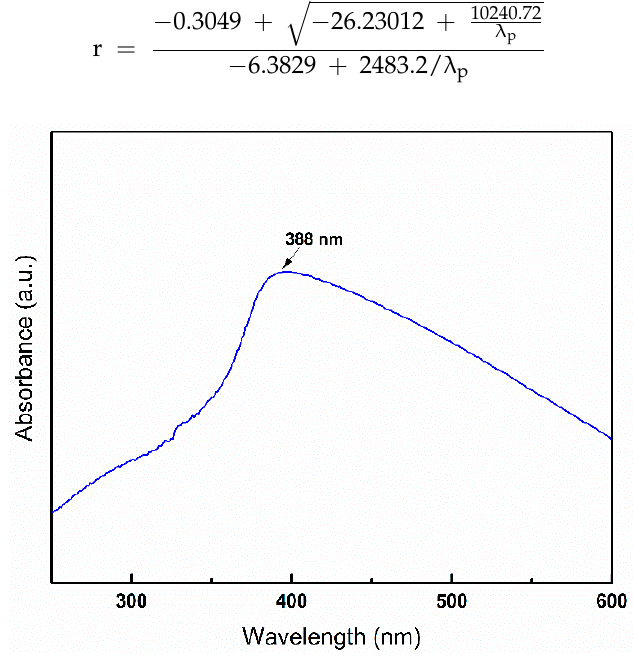
Figure 8. UV-Visible absorption spectrum of synthesised ZnO nanoparticles.